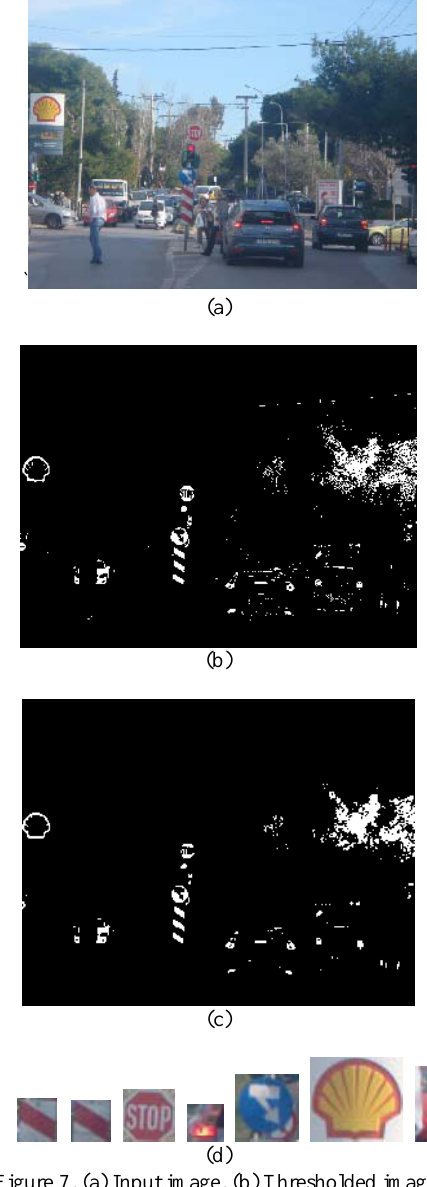
Figure 7. (a) Input image, (b) Thresholded image, (c) Result of median filtering, (d) Extracted ROIs If the ratio between the two vertical sides of the bounding box is lower than 0.7, the ROIs are further processed and shape based detection is applied. For this step 70% of the input ROIs depicting overlapping traffic signs were successfully separated (Figure 8). Even though this detection percentage is not very high, this step is extremely important because if the overlapping traffic signs were imported as one region of interest in the classification procedure, recognition would fail for both of them.